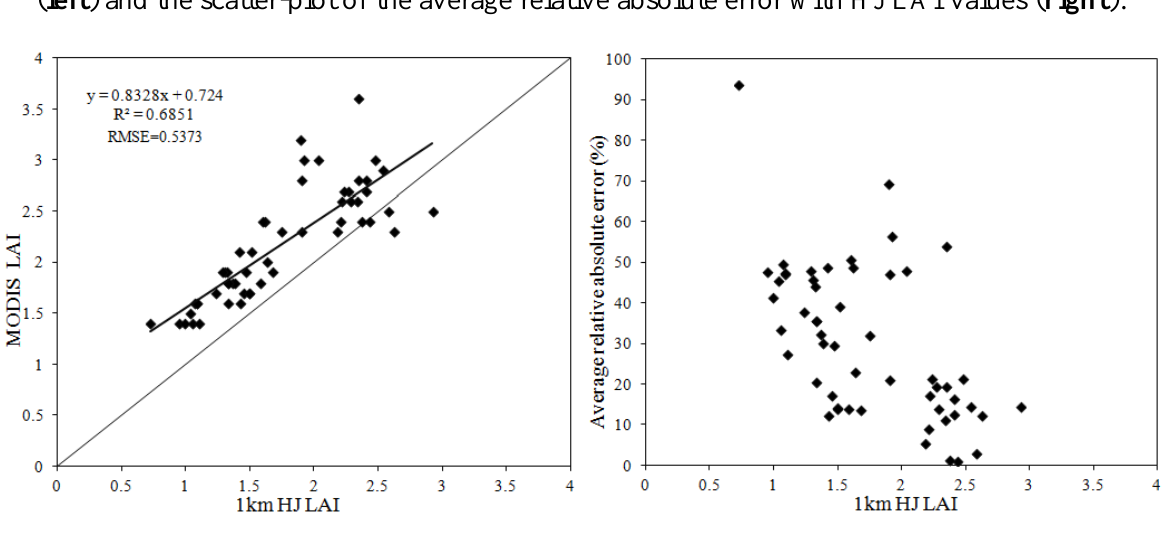
Figure 8. Good agreement was achieved with an R 2 of 0.6851 and RMSE of 0.5373 m 2 /m 2 . However,